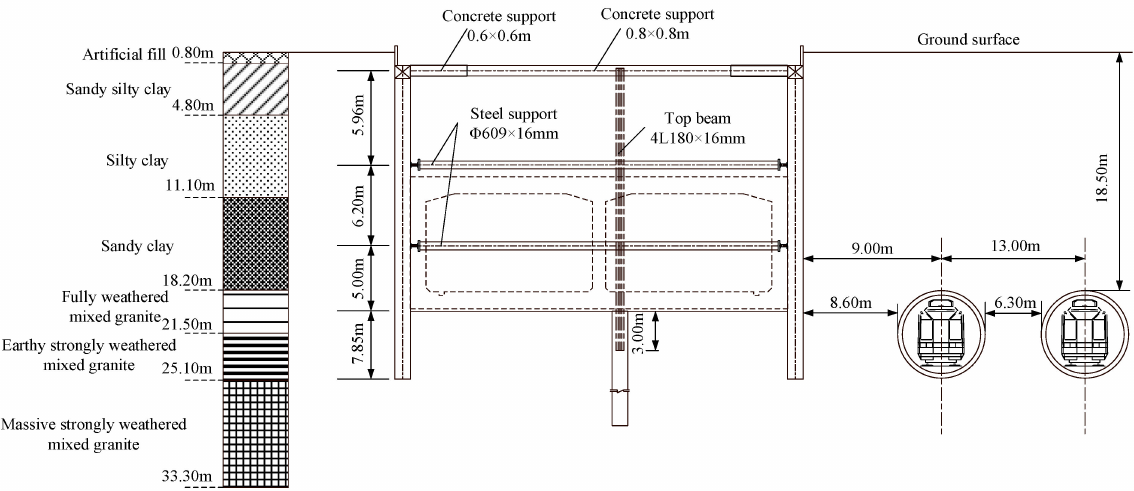
Figure 4. Sectional view of the supporting structure.